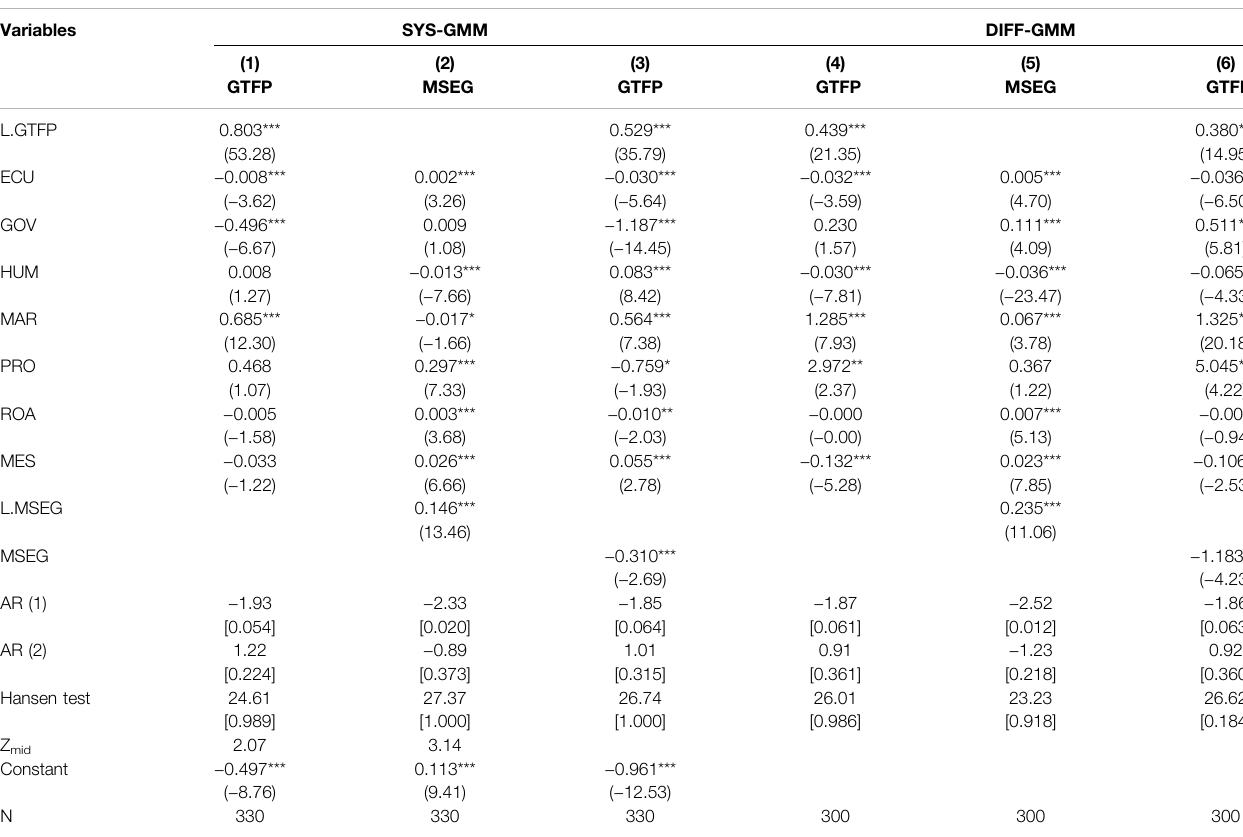
TABLE 6 | Transmission mechanism